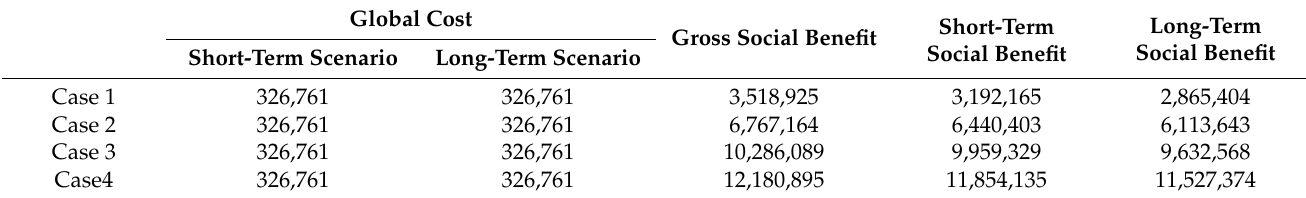
Table 6. Social benefit per class of graduates in the future (EUR, 2019